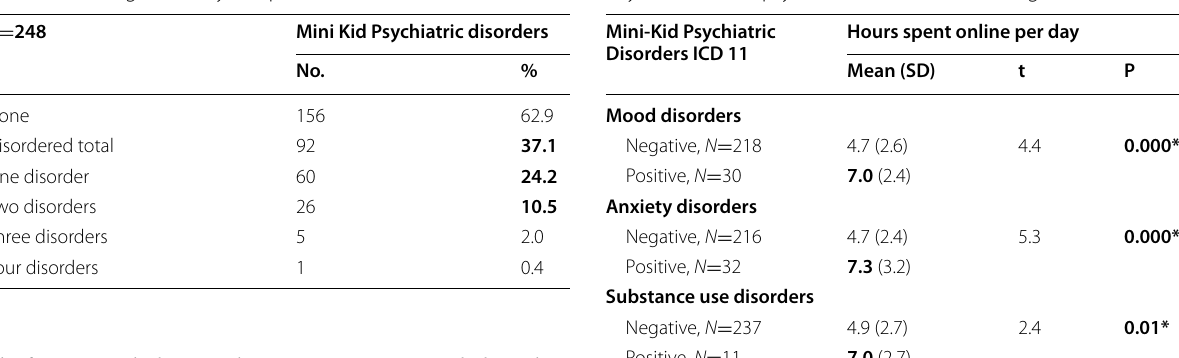
Table 4 Distribution of the results of Mini-kid psychiatric Table 5 Comparison between the mean hours spent online